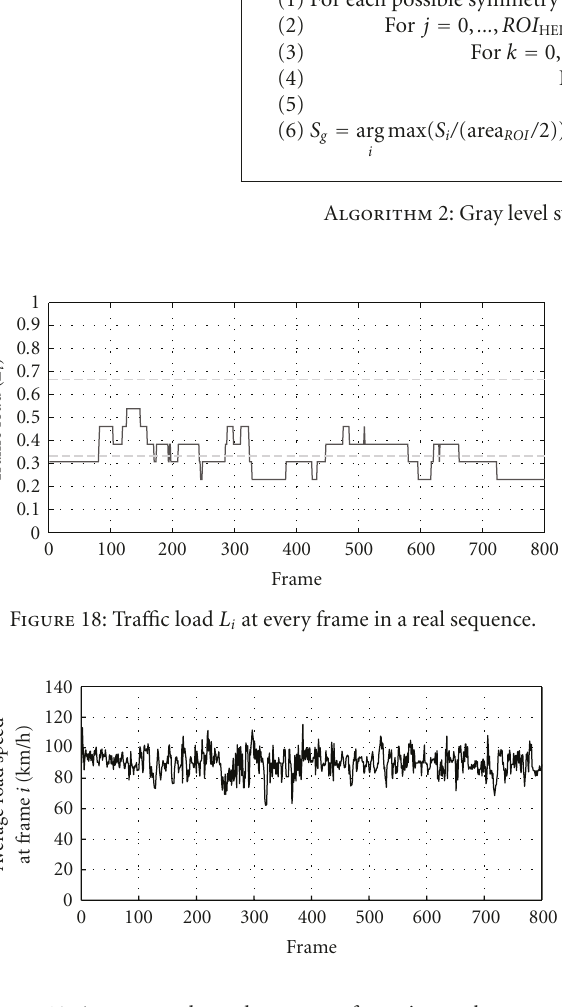
Figure 19: Average road speed v i at every frame in a real sequence.